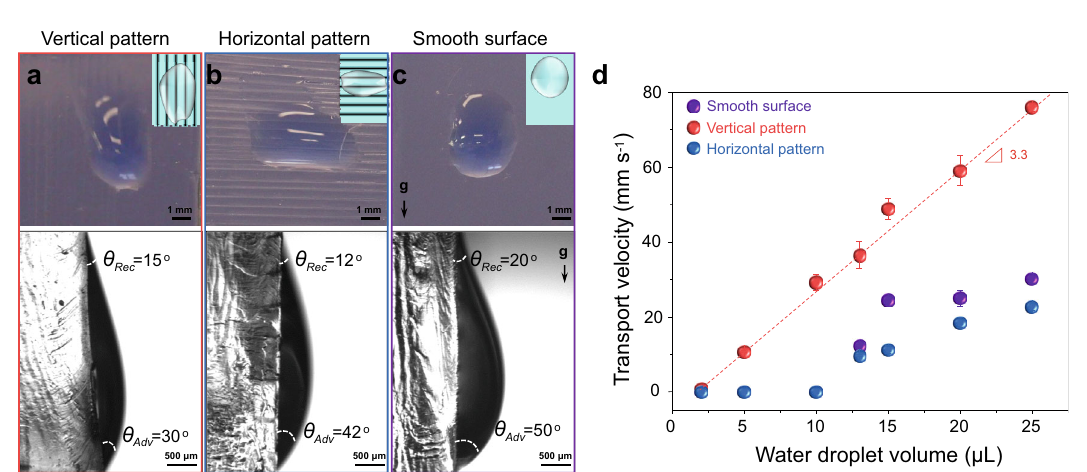
Fig. 6 | An example to show controlled water transportation on DN hydrogels with strip-like PNIPAm patterns. a – c Optical images to show micropattern- dependentmorphologiesandcontactanglehysteresisofwaterdroplets(10 μ L)on DNhydrogelsstandingvertically.Theadvancingangle θ Adv andrecedingangle θ Rec are shown. The letter “ g ” and arrow indicate the direction of gravity for the three samples shown. d Dependence of transport velocity on water droplet volume for